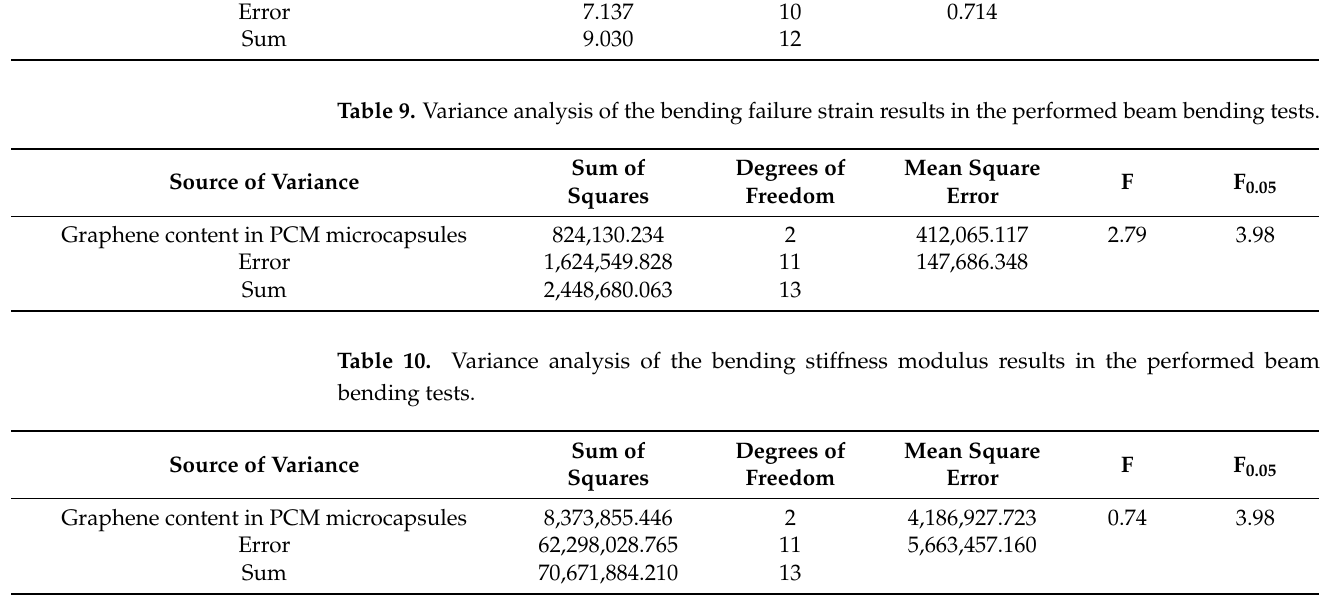
Table 11. Variance analysis of the bending strain energy in the performed beam bending